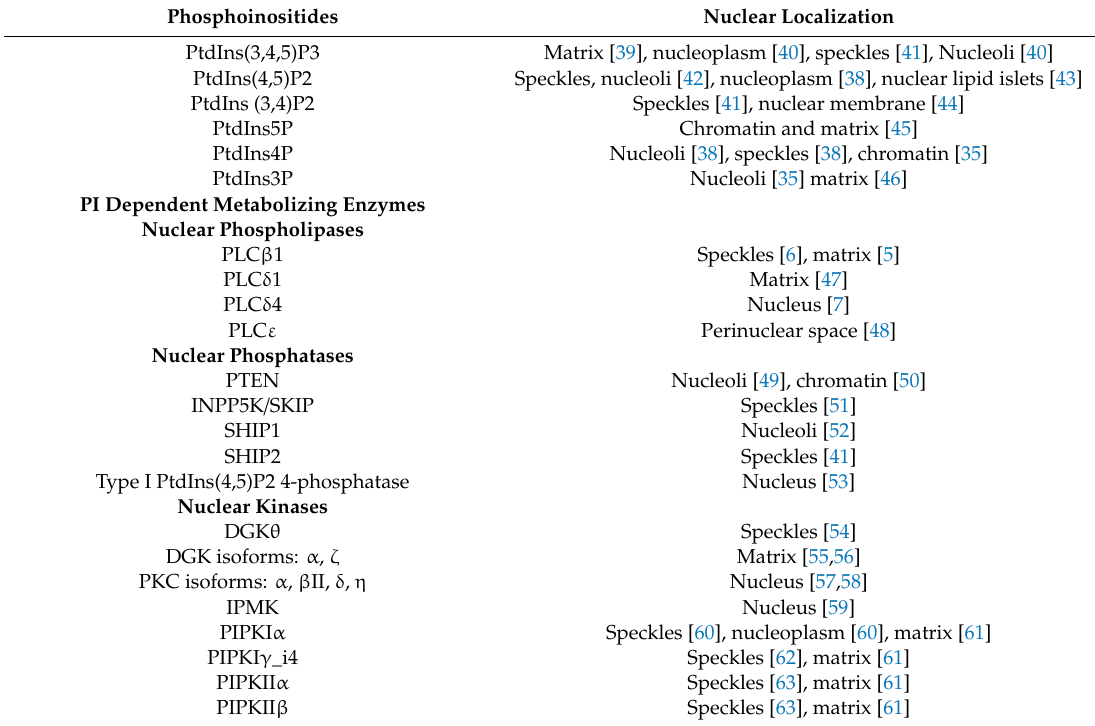
Table 1. Subcompartmental localization of nuclear PIs and their metabolic